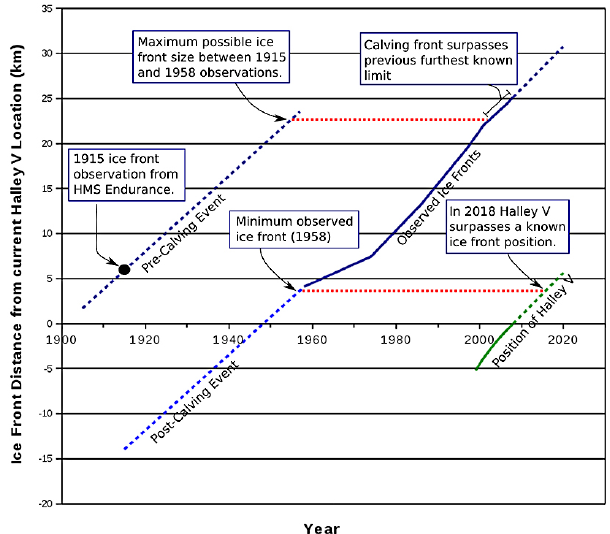
Fig. 5. Position of the BIS ice front measured as a distance along a flow line running through Halley V Research Station. The vertical axis of the figure represents distance along this flow line relative to the 2009 position of Halley V. The thick blue line is based on mea- sured positions of the BIS ice front. The dashed blue lines represent the change in ice-front position with time assuming a constant rate of ice-front advance equal to that observed between 1958 and 2010. The dashed blue line in the upper-left part of the diagram is fixed by the 1915 measured ice-front position. The green line to the lower- right represents the change in the position of Halley V with